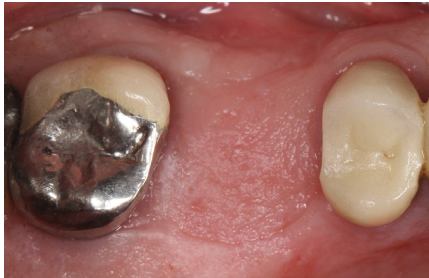
Figure 7: The site of #3, 3 months after the ridge preservation showed complete epithelization.